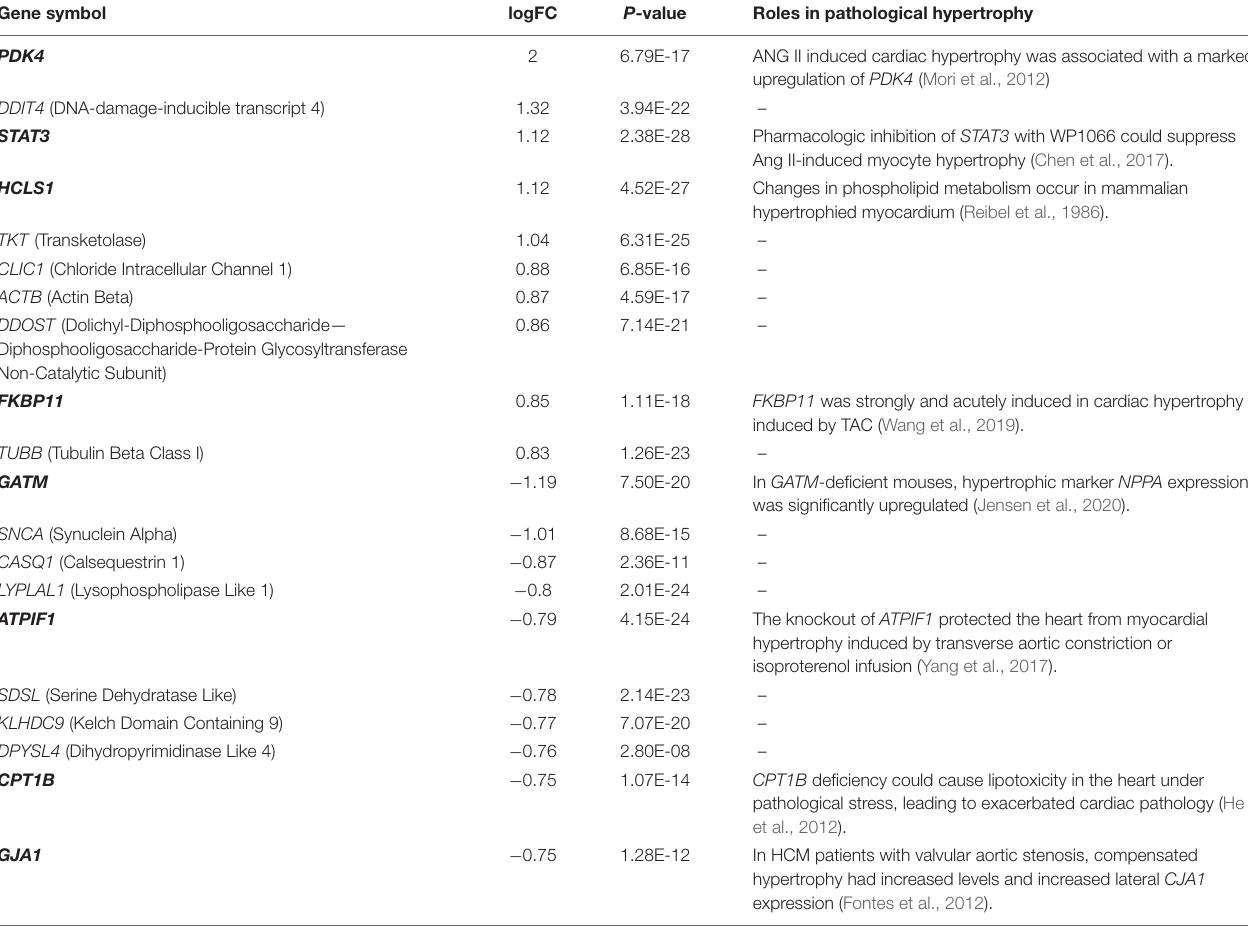
TABLE 1 | Top 10 upregulated and top 10 downregulated DE-NMGenes.